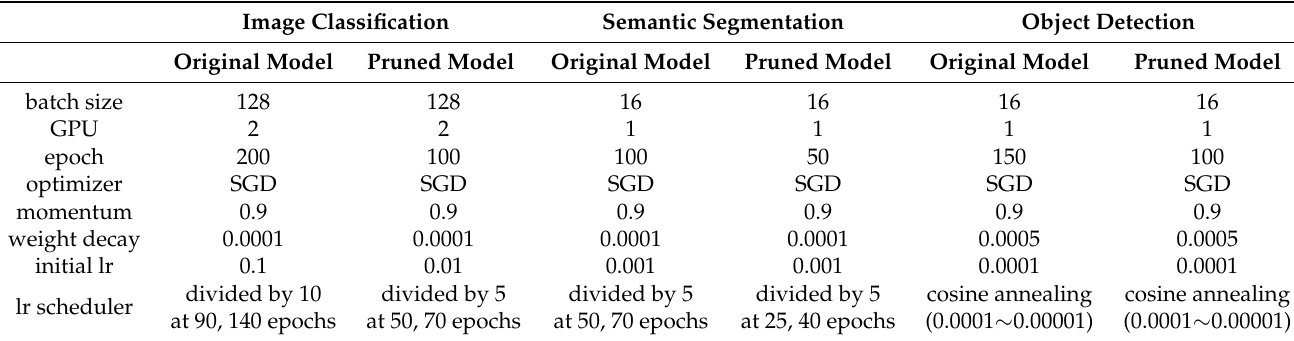
Table 1. Hyperparameters of original and pruned